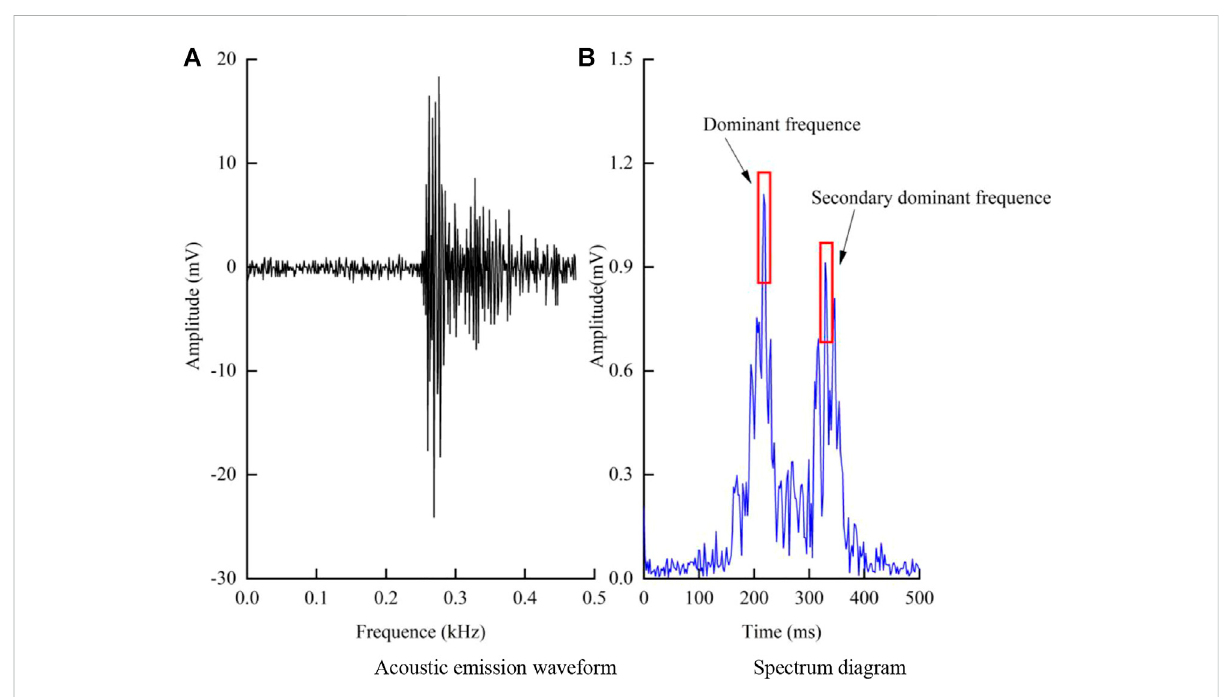
FIGURE 4 Waveform and spectrum of acoustic emission signal. (A) Acoustic emission waveform (B) Spectrum